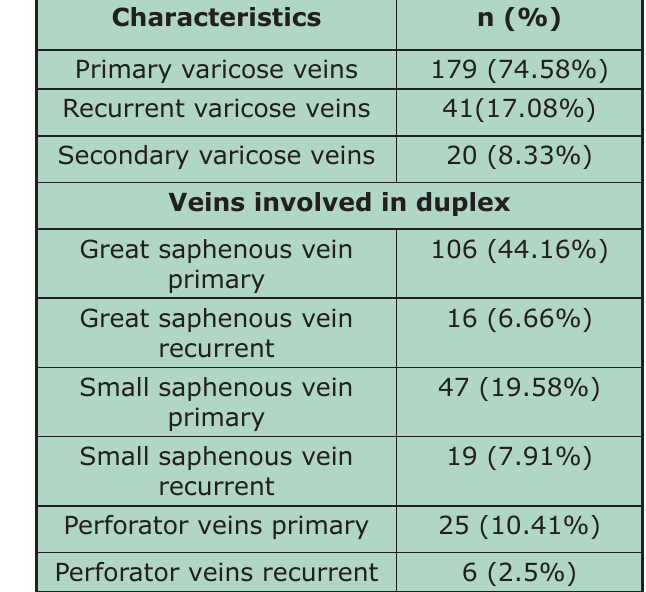
Table-II:Pretreatment duplex findings